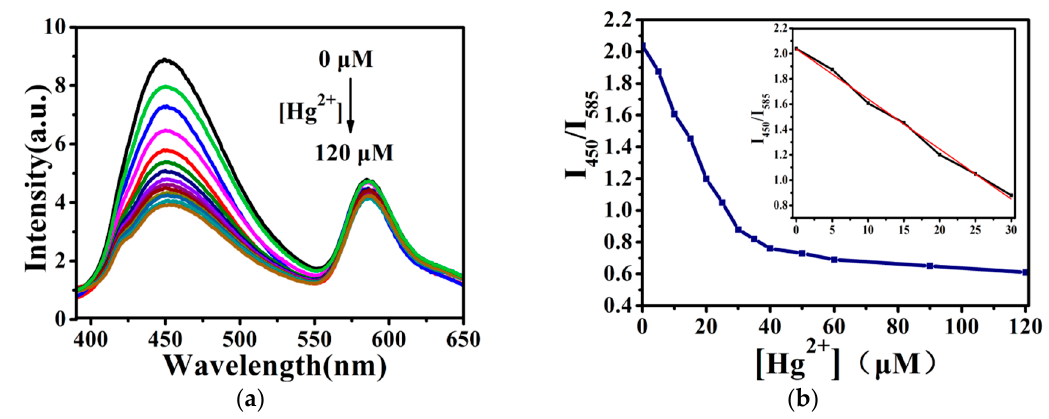
Figure 7. ( a ) Fluorescence spectra change of dual-emission silica microspheres upon addition of different concentrations of Hg 2+ (excited at 360 nm). The concentration of Hg 2+ from 0 to 120 μ M; ( b ) fluorescence intensity ratio of F 450 /F 585 versus Hg 2+ concentration. Inset: linear fitting curve of F 450 /F 585 versus a different concentration of Hg 2+ .